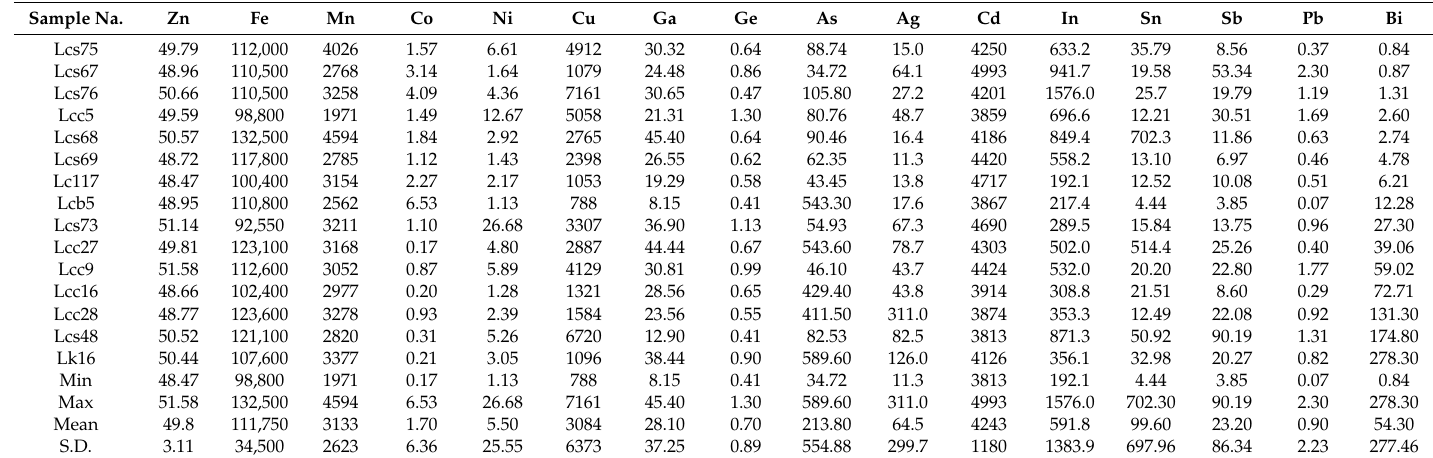
Table 3. Trace elements in sphalerite from stratabound ores of Laochang